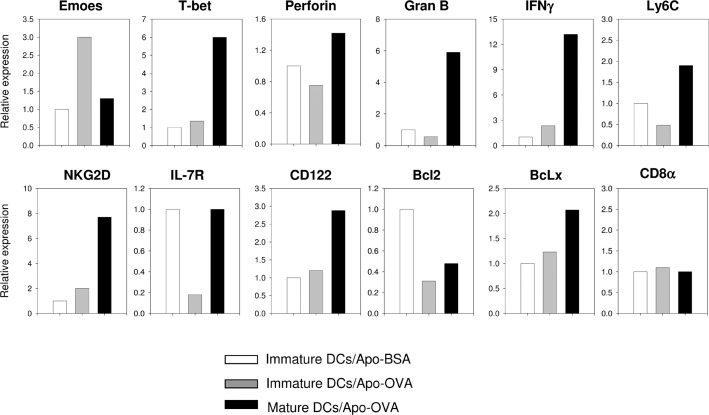
Cross-presentation of apoptotic cell associated antigen by immature dendritic cells down-regulates IL-7R on CD8 T cells.2 x106 purified CD45.1+ OT-I T cells were transferred into CD45.2+ mice. One day after the transfer, recipients were challenged with 2 x 106 immature dendritic cells loaded with Apo-BSA, or 2 x 106 immature dendritic cells loaded with Apo-OVA, or 2 x 106 LPS matured dendritic cells loaded with Apo-OVA (n = 5 for each group). At day 7 after challenge, spleen cells from each group were pooled and the transferred OT-I T cells were recovered using anti-CD45.1 biotin beads. RNA from the pooled samples was isolated and reverse-transcribed to cDNA. Relative levels of mRNAs of indicated genes were determined by real-time PCR. Similar results were obtained from two experiments.